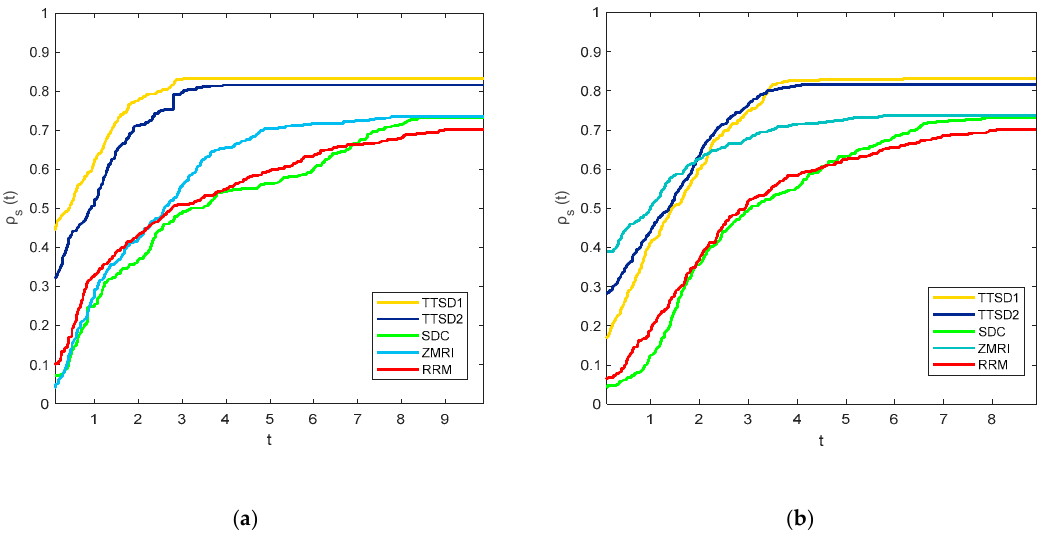
Figure 1. Performance profile using exact line search procedures between steepest descent (SD) methods based on the ( a ) number of iterations evaluation; ( b ) CPU time.